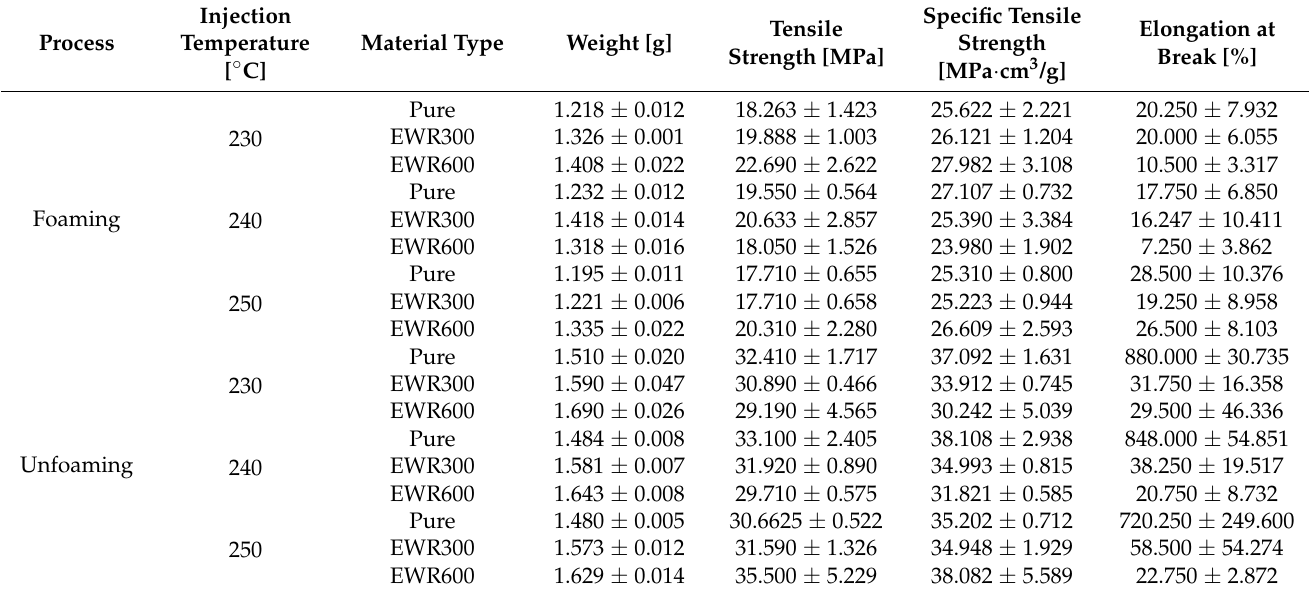
Table 3. Weight, tensile strength, specific tensile strength, and elongation at break of the tensile